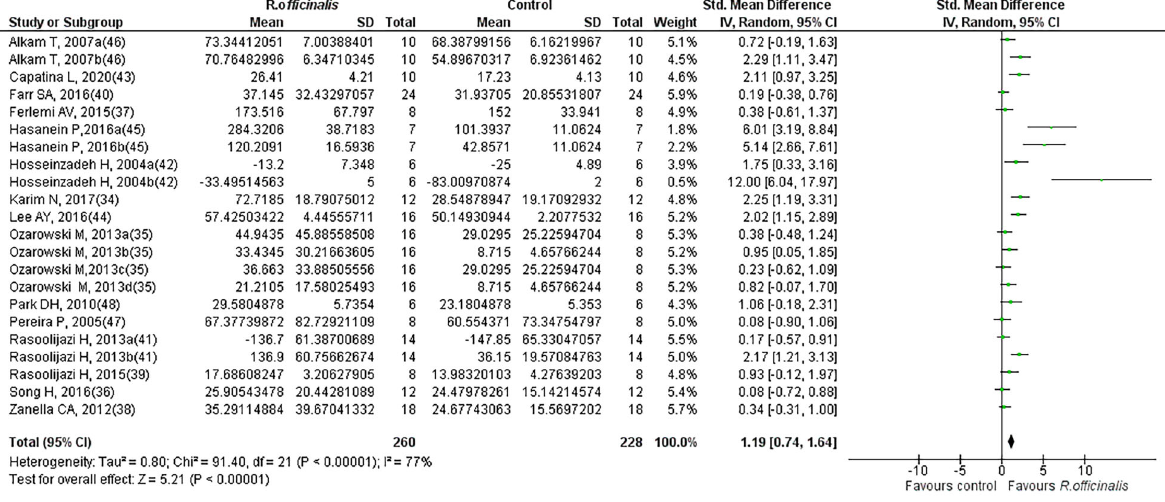
Figure 3. Forest plot of the effect of R. of fi cinalis on cognitive performance in lab